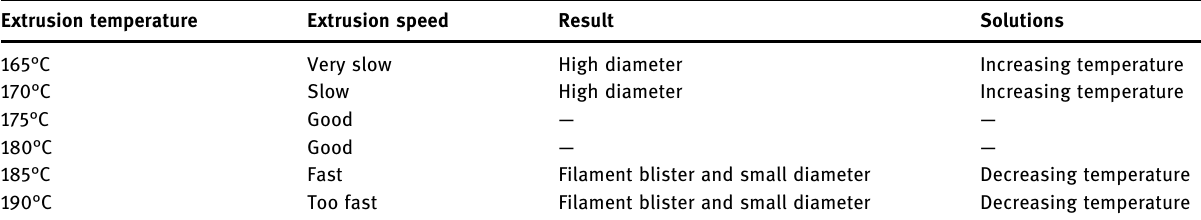
Table 2: Extrusion parameters